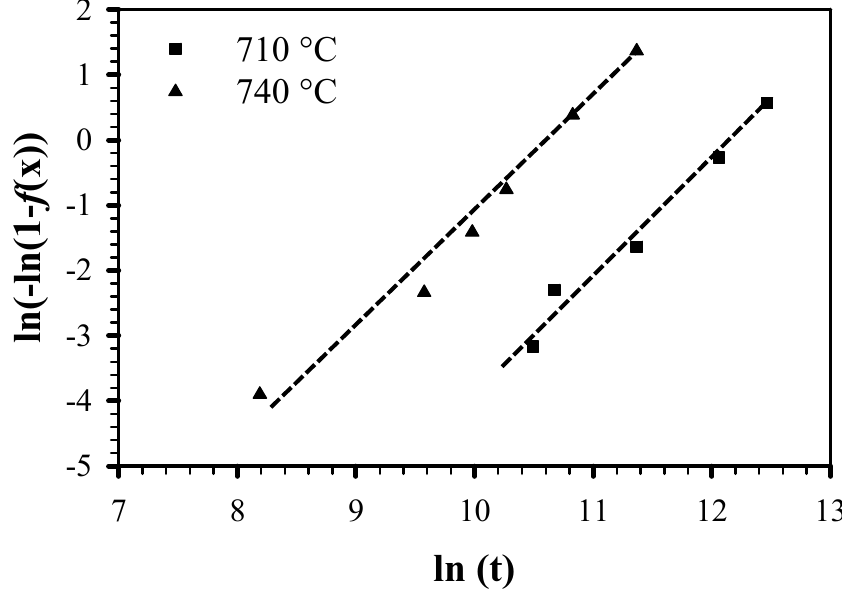
Figure 7. Kinetics of abnormal grain growth at 710 and 740 °C during isothermal annealing.